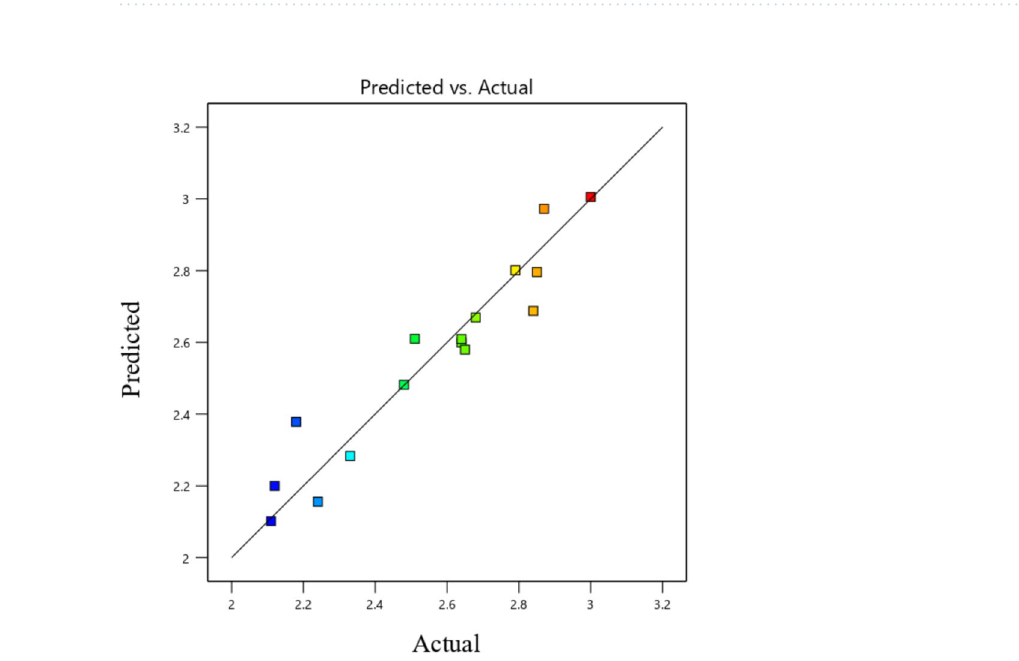
Table 3. The variance analysis (ANOVA).